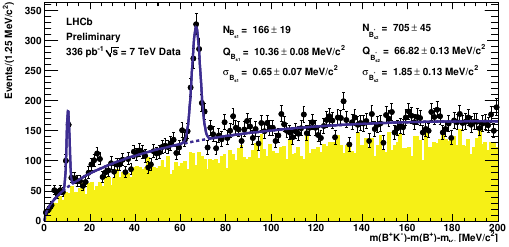
Figure 5. Q ( B + K − ) distribution. LHCb data (black markers) and the total fit are superimposed.